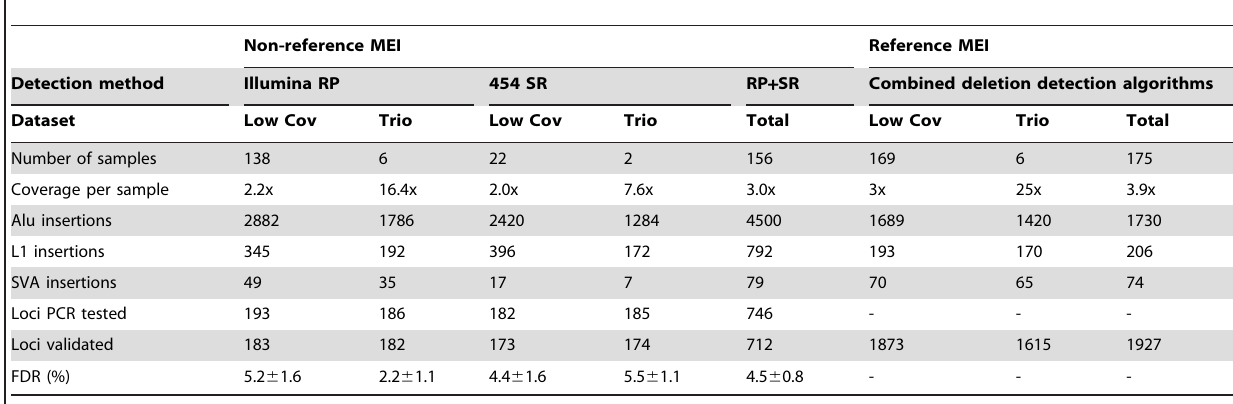
Table 1. 1000 Genomes Project pilot data used for mobile element insertion